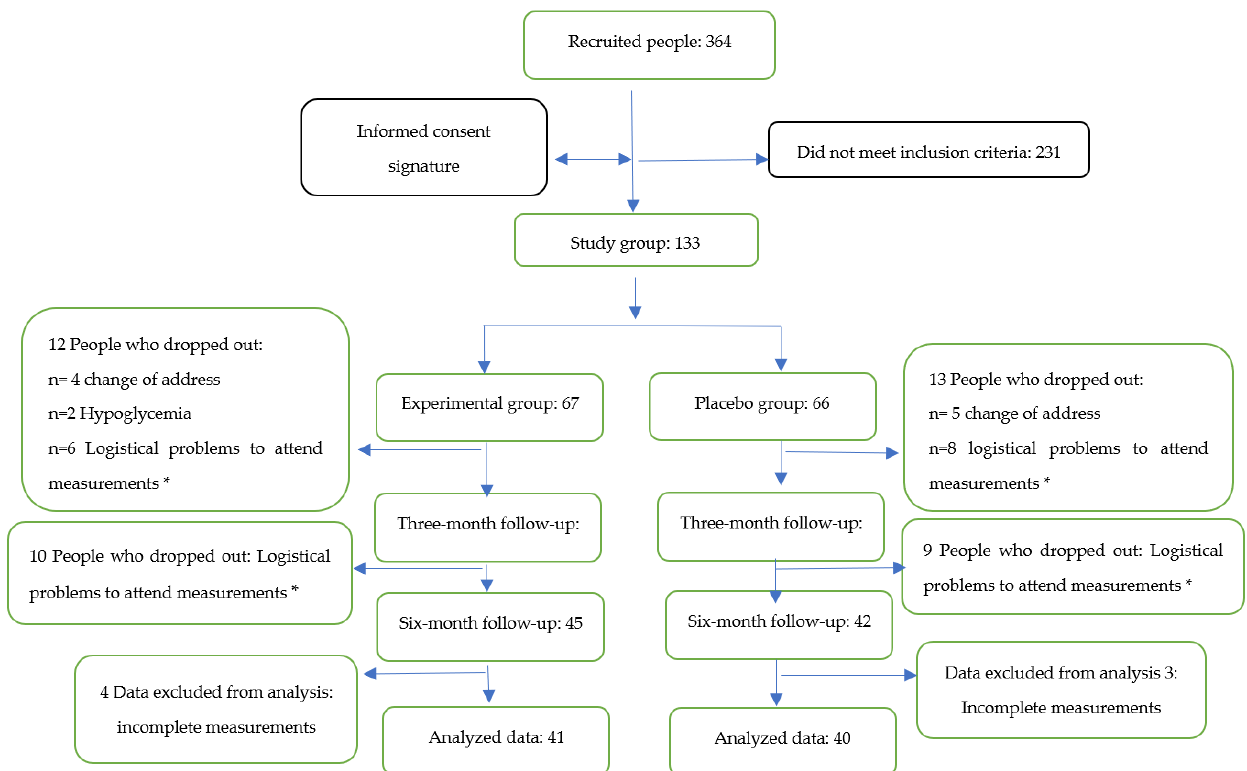
Figure 1. A general outline of the study. * Logistic problems: refers to medical appointments at a different location on the day of the measurement, lack of a companion, long distances to travel, and not enough time available to travel to the location.